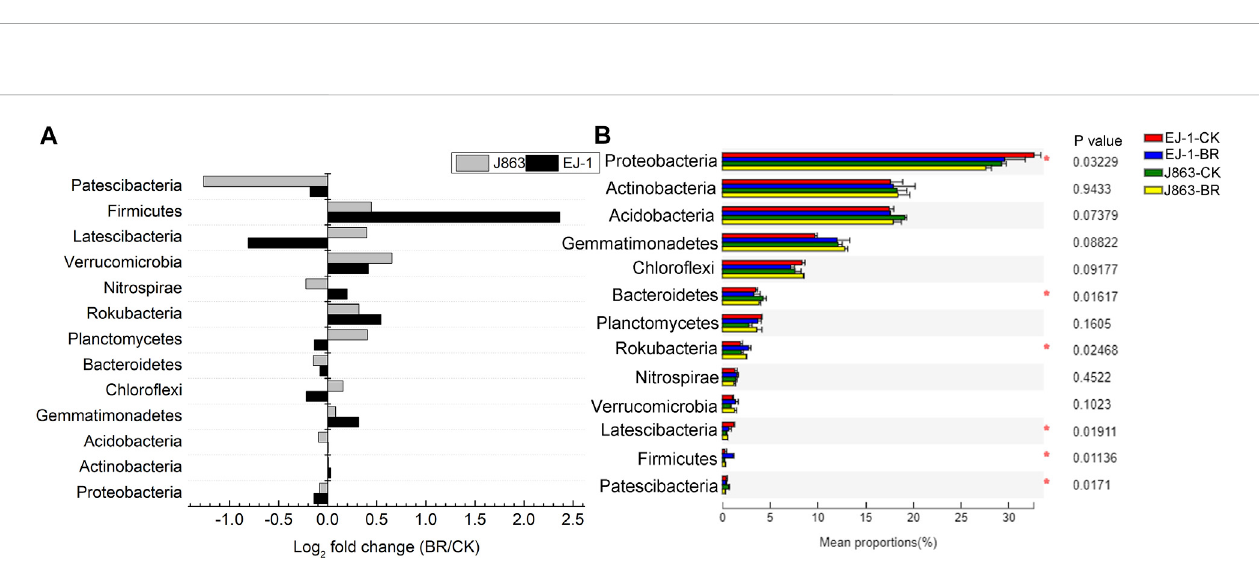
FIGURE 5 Relativeabundanceofthedominantbacterialtaxaatthephylumlevelunderdifferenttreatments. (A) Logarithm offoldchangesofBR/CK, (B) ,Analysisof signi fi cant differencesin meanproportion ofdominant bacterial. Log 2 fold change < 0represents therelativeabundanceof taxadecreased, Log 2 fold change > 0 represents the relative abundance of taxa increased. CK represents treatment with blank control, BR represents treatment with broccoli residues. EJ-1 represents susceptible cultivar for CVW, J863 represents resistant cultivar for CVW. Asterisk represents signi fi cantly different byDuncan ’ s multiple range test at P <